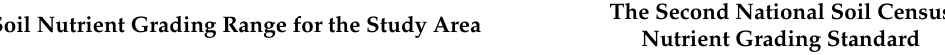
Table 1. The soil nutrient grades for the study area and comparison with the Second National Soil Census Nutrient Grading